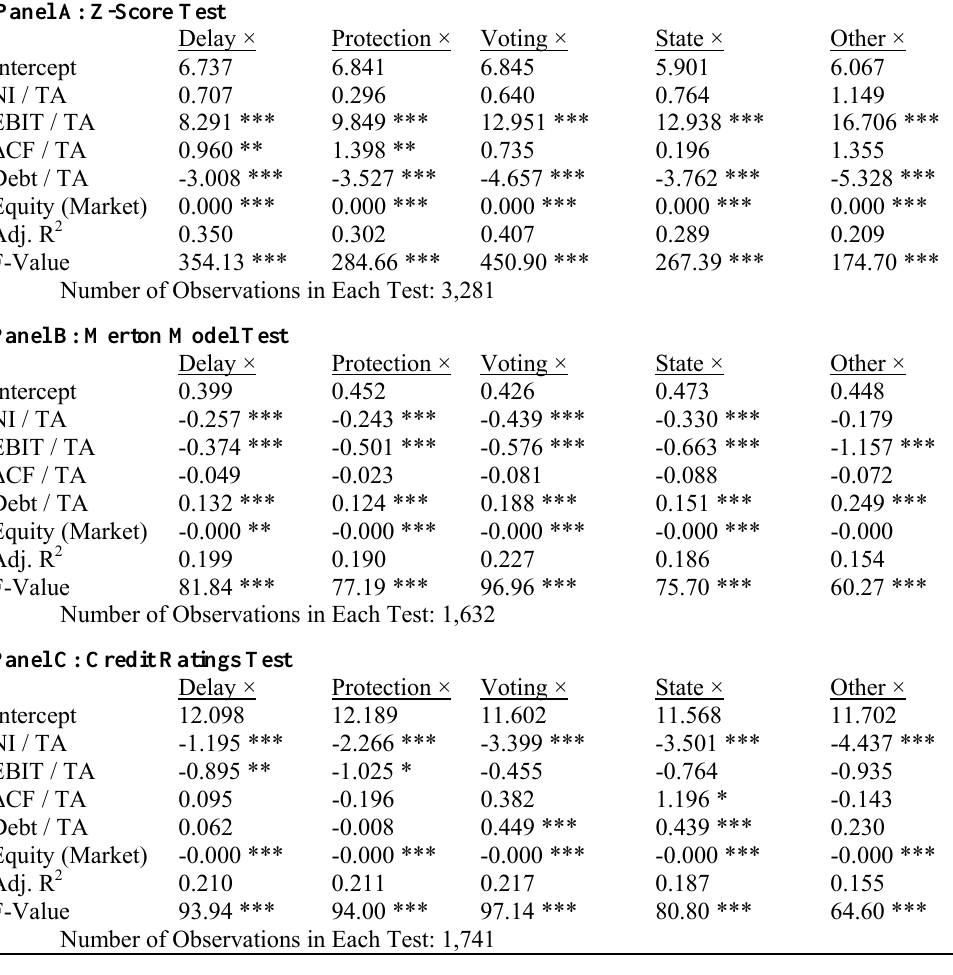
Table 6. Summary Results for the Interaction Terms